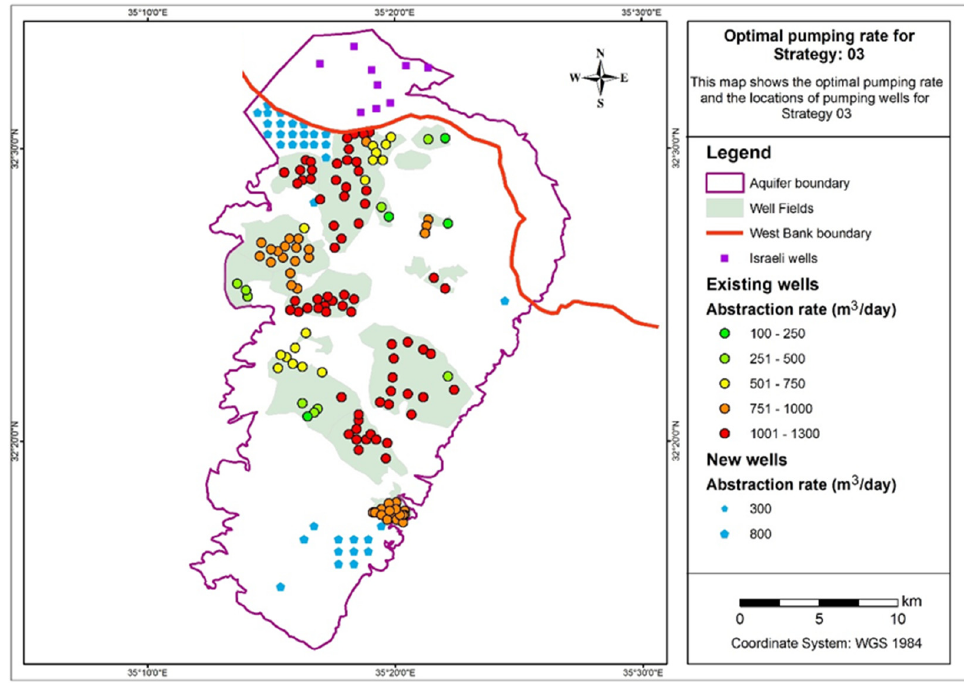
Figure 22. Wells distribution and water balance results for Strategy 03.